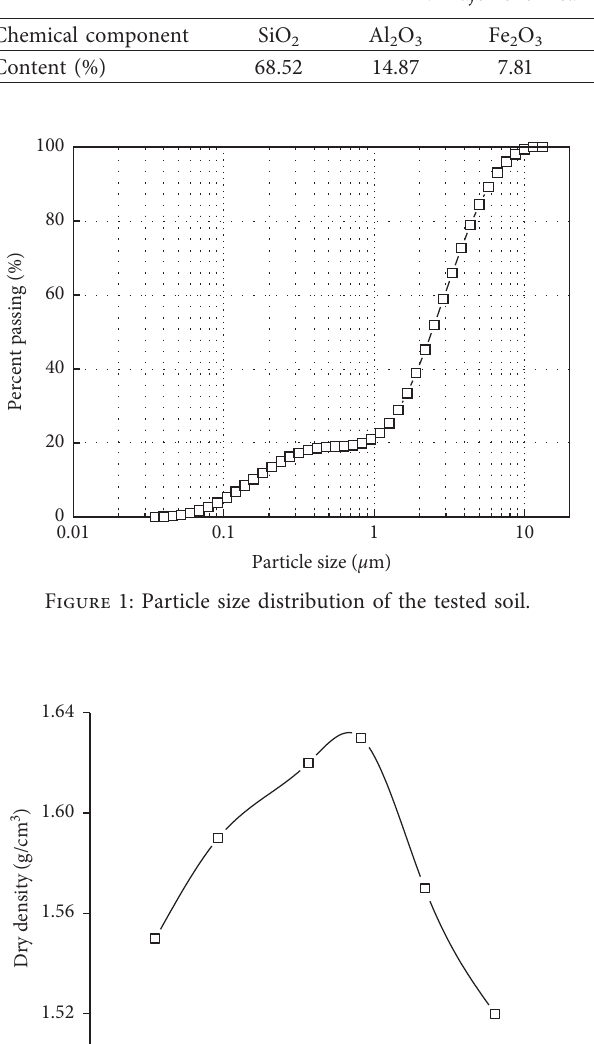
Table 2: Major chemical components of the tested soil.